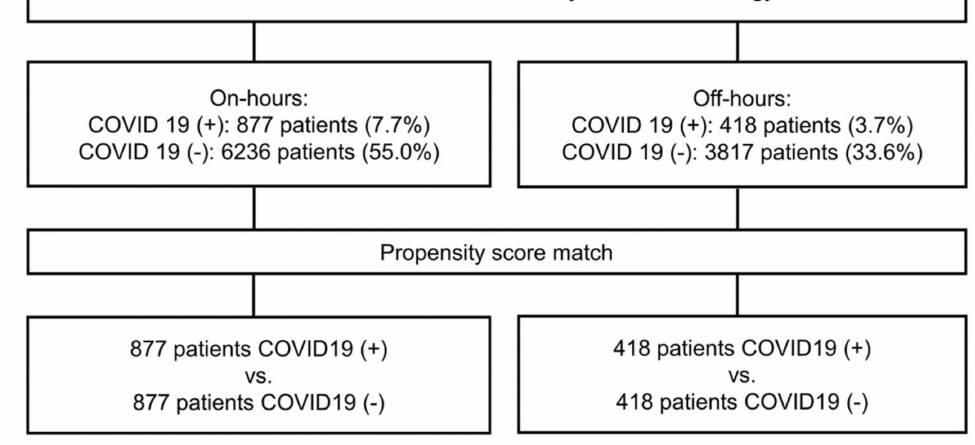
Figure 1. Flowchart of included patients. PCI—percutaneous coronary intervention; STEMI—ST- segment elevation